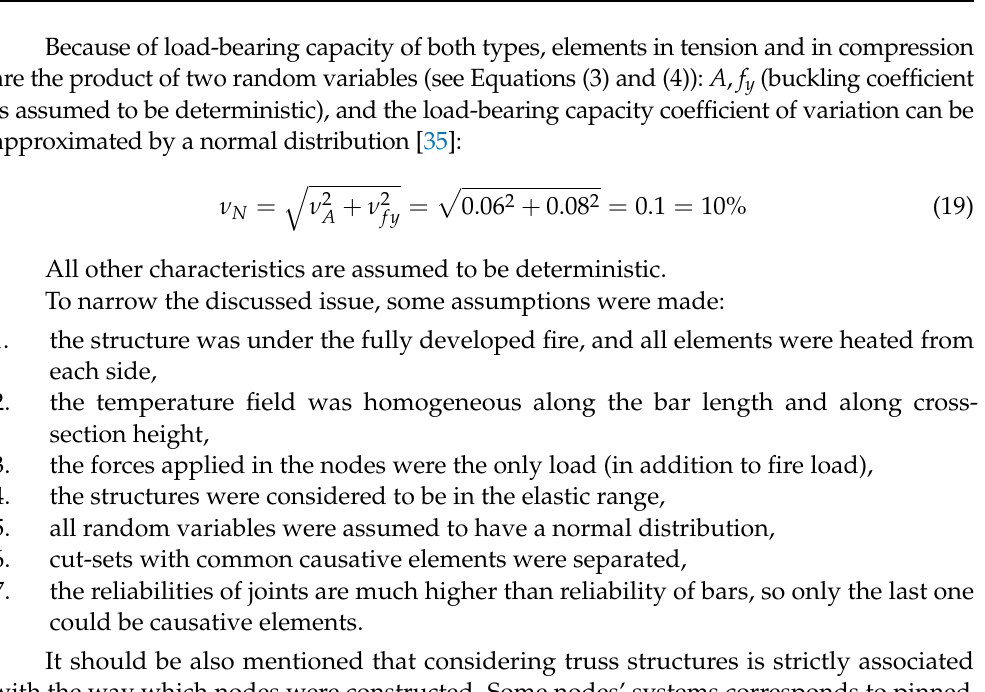
Table 1. Coefficients of variation for random variables. Variable Symbol Coefficient of Variation ν [%] Effect of action E 6 Cross-sectional area A 6 Yield strength f y 8 Load bearing capacity N 10